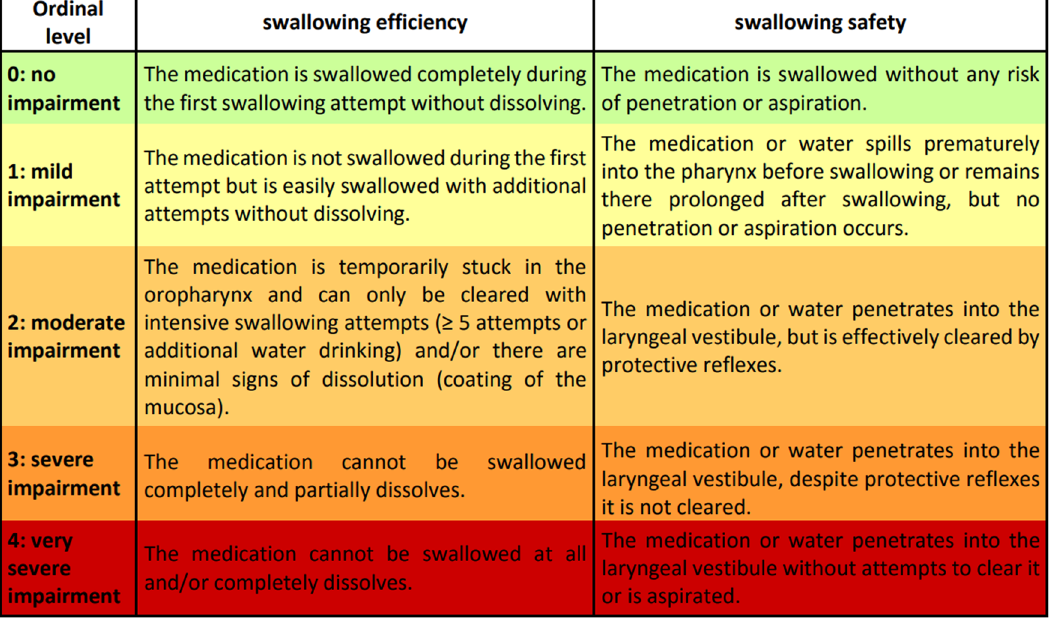
Fig. 1 Classi fi cation of Dysphagia for Medication. Illustration of the 5-point ordinal scales of impairment in swallowing ef fi ciency and swallowing safety.